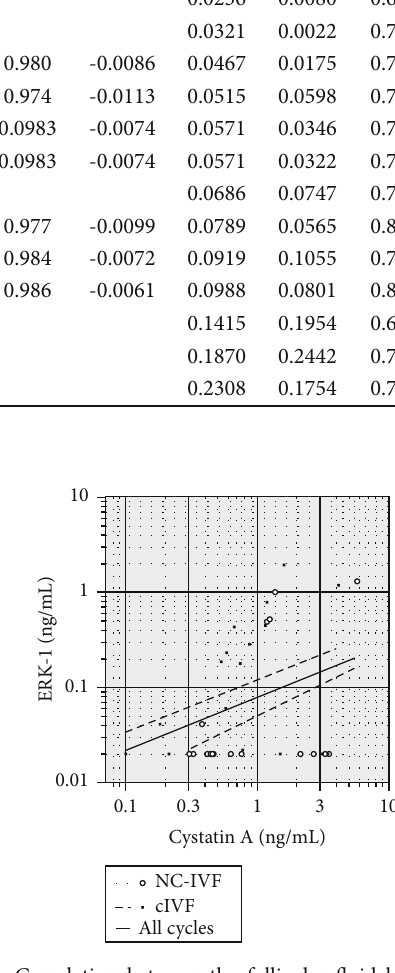
Figure 1: Follicular fl uid levels of Cystatin A, GAD-2, and ERK-1 as determined by ELISA. Open circles, NC-IVF. Closed circles, cIVF (conventional stimulation with gonadotrophins). P values were obtained by the Wilcoxon signed rank test which takes the e ffi cient pairing into account (the di ff erence in the values between both cycles in the same patient, 15 sample pairs). The graph also includes the results from samples for which the pairing had not been possible due to an insu ffi cient available volume. Please note the logarithmic scale.